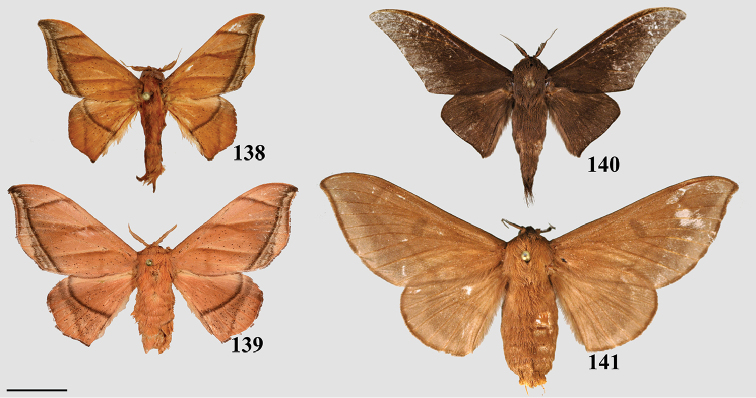
Adult specimens of type species of genera belonging to Cicinninae: Psychocampini. 138Biterolfaalthea, male [reused with permission from St Laurent et al. (2017d), Tropical Lepidoptera Research] (NHMUK) 139Biterolfaalthea, female [reused with permission from St Laurent et al. (2017d), Tropical Lepidoptera Research] (CDH) 140Psychocampaconcolor, male [photo R Lahousse] (MNHN) 141P.concolor, female [photo R Lahousse] (MNHN). Scale bar: 1 cm.